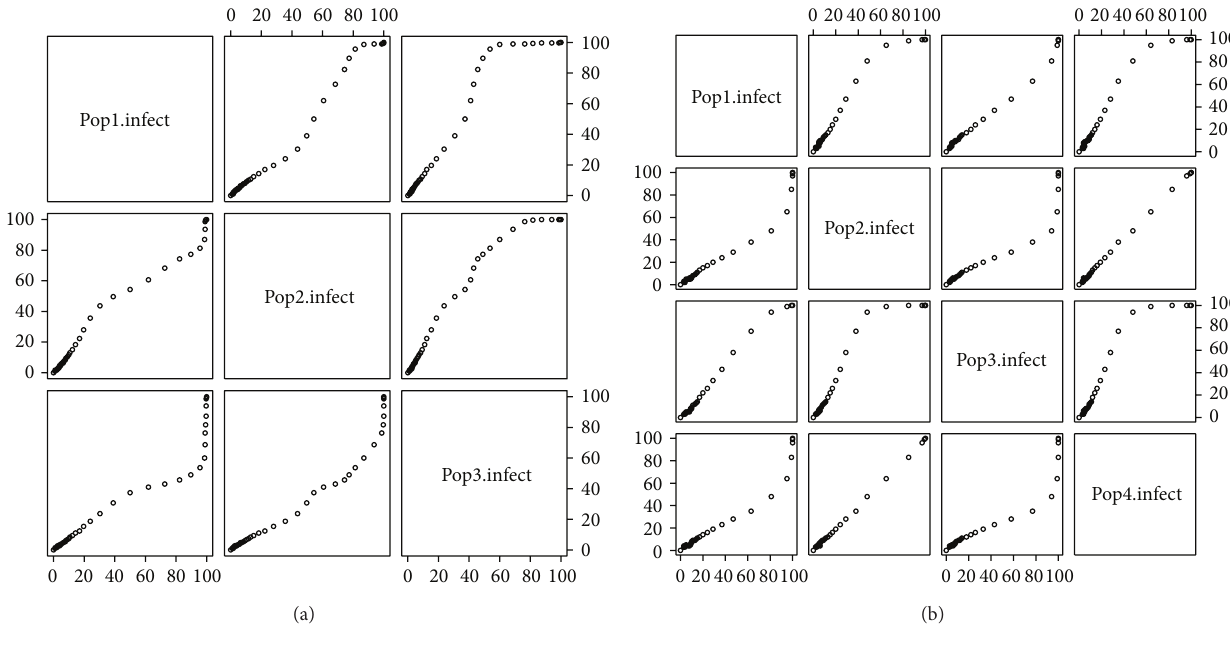
Figure 6: Number of populations.